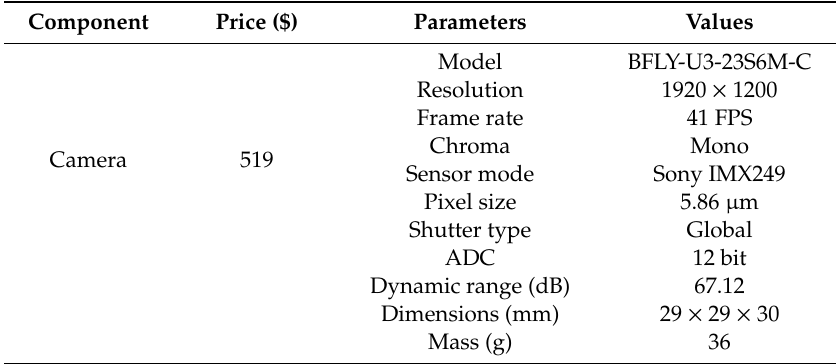
Table 1. Specifications of the LeafScope